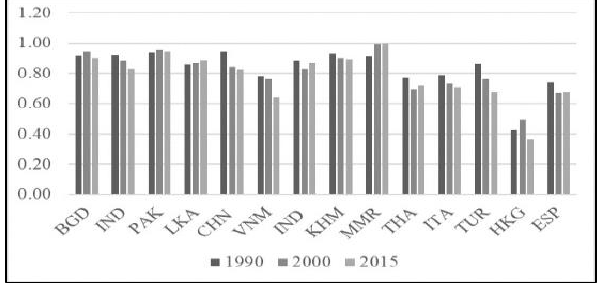
Figure 1: Value-added export (VAX) ratio from country; Source: